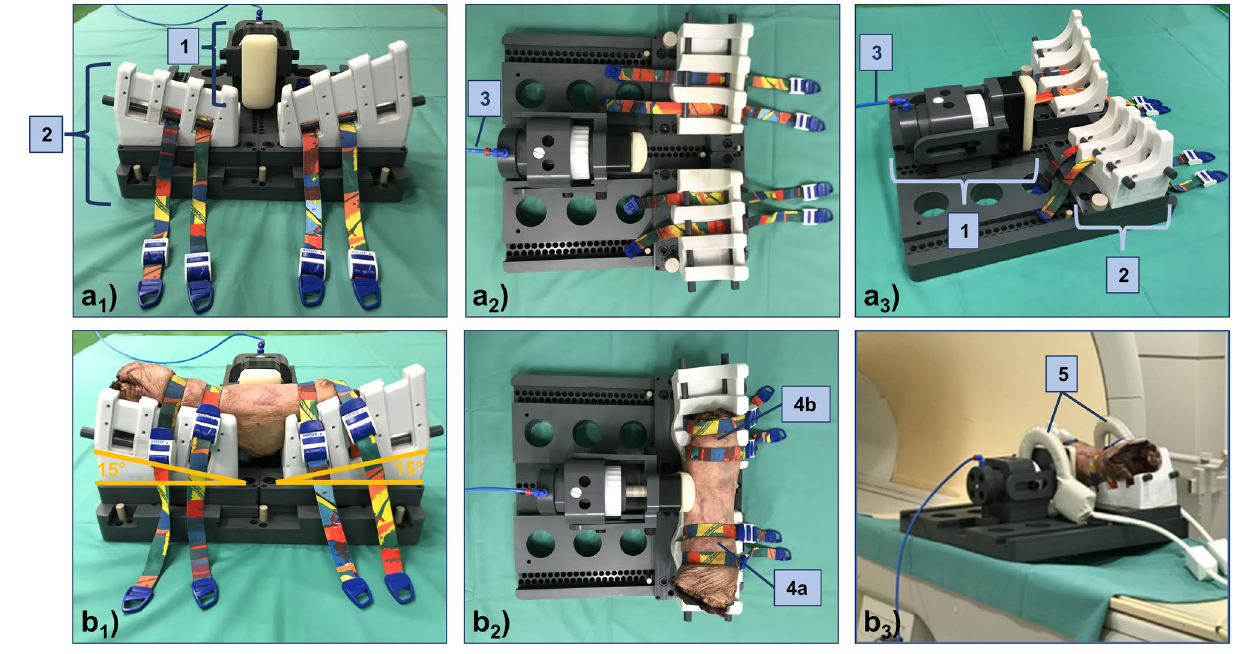
Figure 3. Setup for varus stress MRI. The MRI-compatible loading device is shown without ( a ) and with ( b ) a representative (left-sided) knee joint specimen. Side views ( a 1 , b 1 ), top views ( a 2 , b 2 ), and oblique views ( a 3 , b 3 ). Loading unit (1), holding unit (2), standard pressure line (3) to connect the loading unit and the control unit (latter one not shown). Upper (4a) and lower (4b) thigh at 30° of flexion (patella facing downwards). Dual coils (5) were used for imaging.